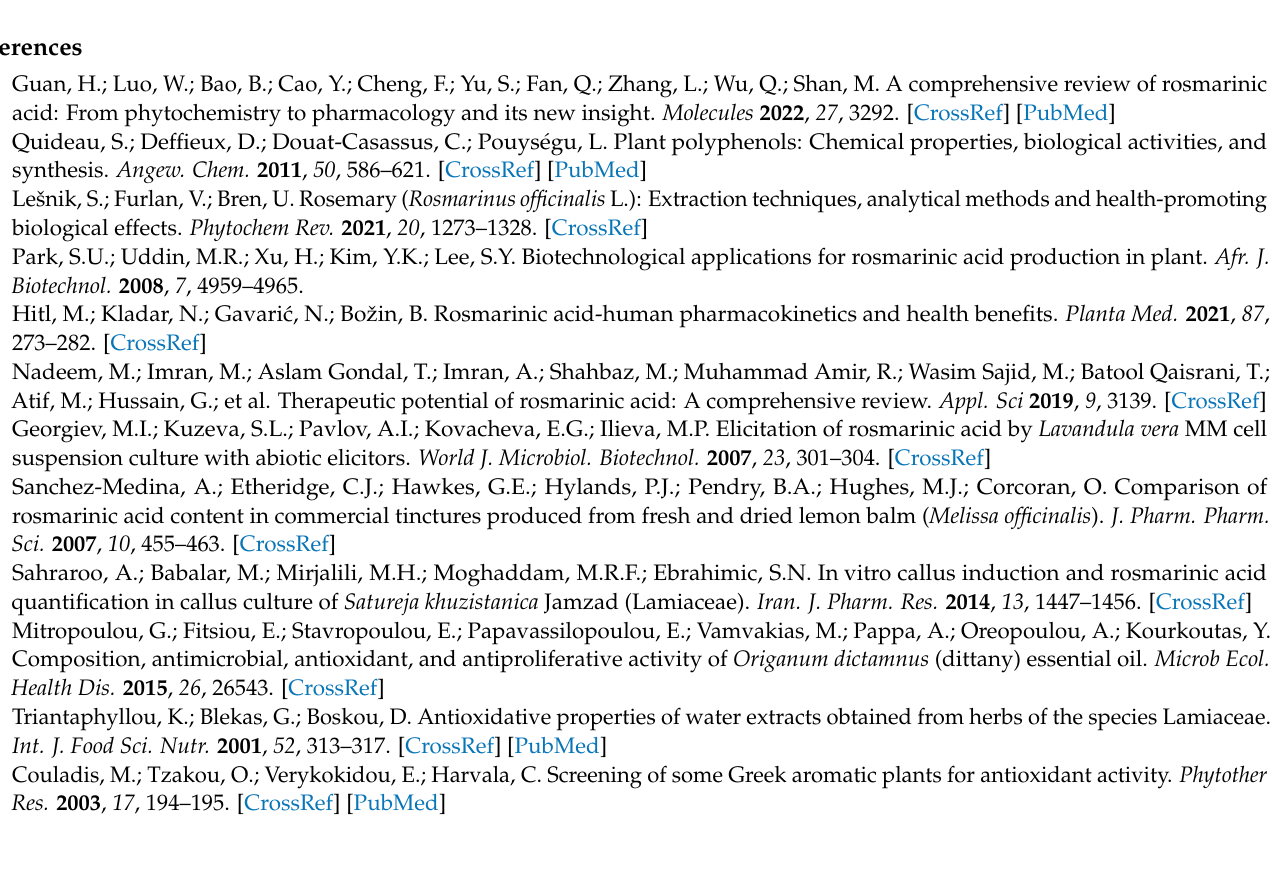
extract; Figure S3: Representative chromatograms of the Origanum dictamnus leaves at 330 nm. Peak at 24.65 min belongs to rosmarinic acid. Differences in the retention time with Figure S1 are due to differences in the elution program; Figure S4: Representative chromatograms of the Origanum dictamnus petioles at 330 nm. Peak at 24.65 min belongs to rosmarinic acid. Differences in the retention time with figure S1 are due to differences in the elution program; Figure S5: Representative chromatograms of the Origanum dictamnus roots at 330 nm. Peak at 23.18 min belongs to rosmarinic acid. Differences in the retention time with Figure S1 are due to differences in the elution